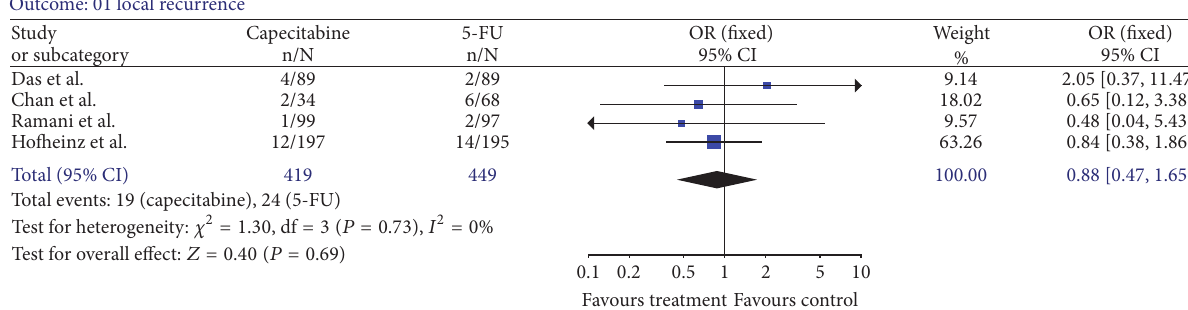
Figure 9: Forest plot of odds ratio (OR) for local recurrence rate.